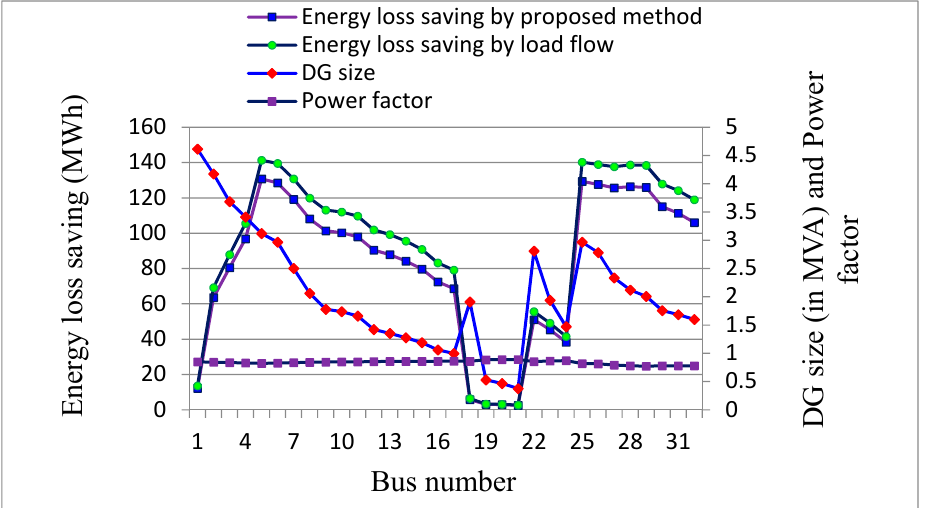
Figure 14. DG units’ size (in MVA), power factor and energy loss saving (in MWh) at various nodes for the IEEE 33-bus radial distribution system.